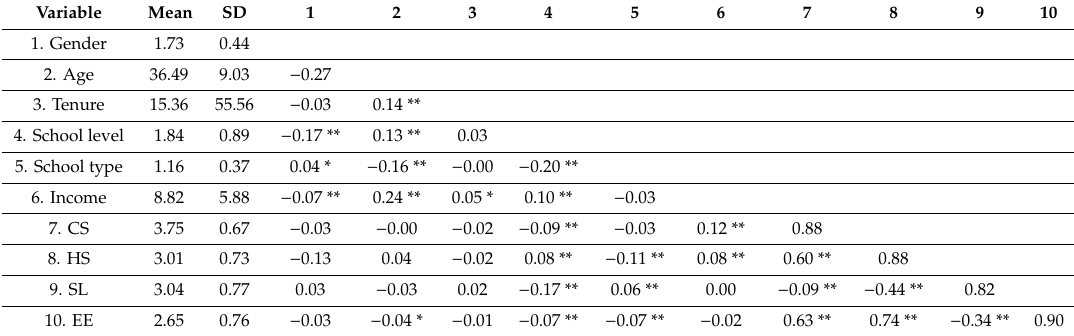
Table 2. Means, standard deviations, reliabilities, and intercorrelations among